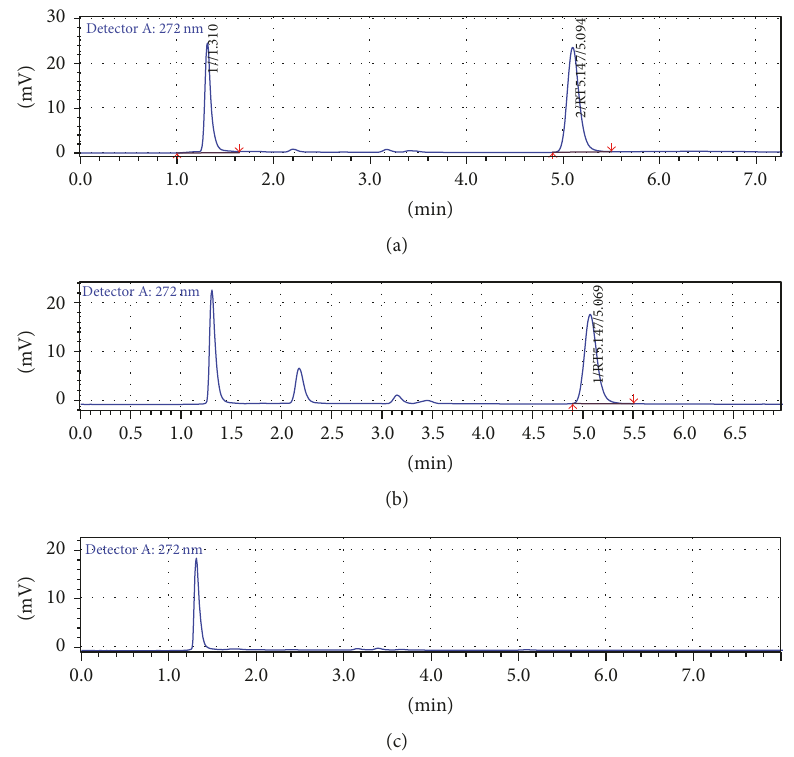
Figure 3: Chromatograms indicating acid hydrolysis degradation of pro-NP. (a) is the chromatogram of pro-NP in 0.1 N HCl at zero time. (b) is the chromatogram of pro-NP in 0.1N HCl after 24 h. (c) is the chromatogram of a blank in the same